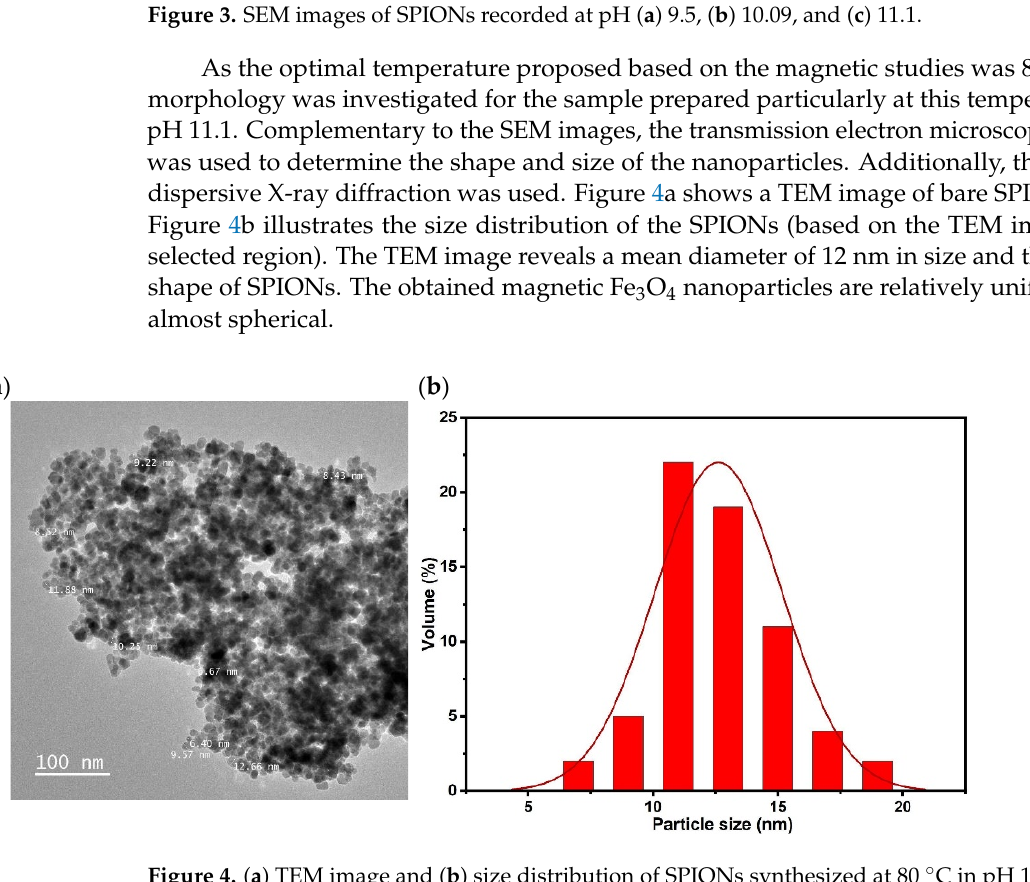
( b ) Figure 5. ( a ) DLS analysis ( b ) FT-IR analysis of SPIONs before and after modification with citrates.